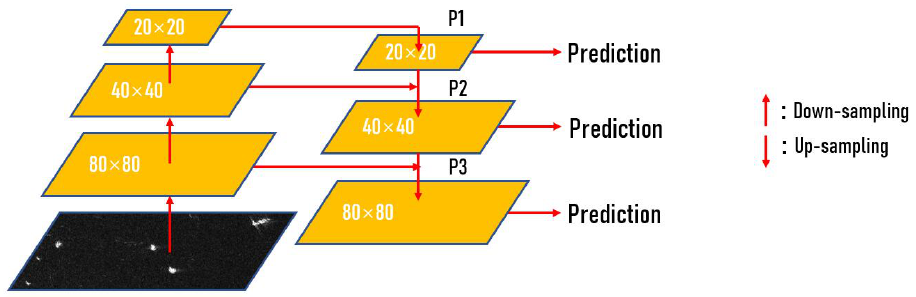
Figure 4. Structure of